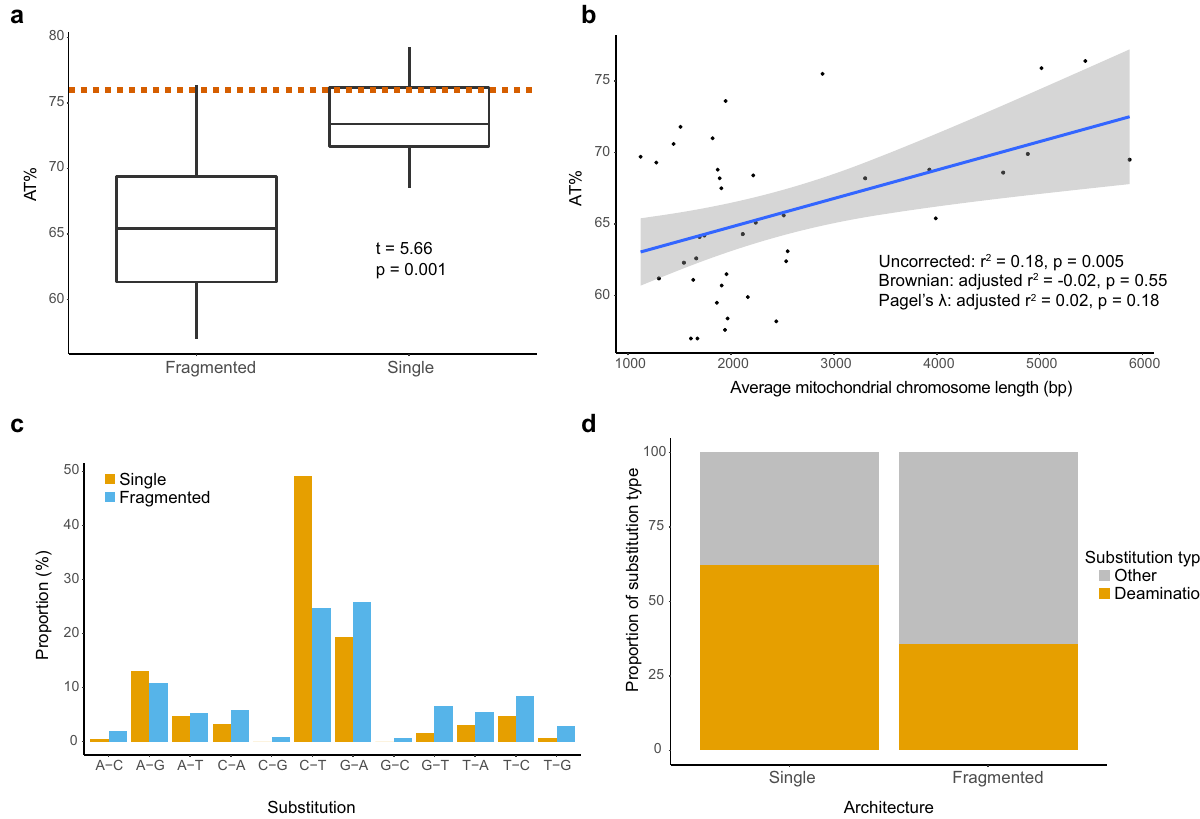
Fig. 5 Patterns of AT% in fragmented versus single-chromosome mitogenomes in parasitic lice. a Box-and-whisker plot comparing AT% from fragmented and single-chromosome mitogenomes in lice (center line: median; box limit: upper and lower quartiles; whiskers: interquartile range). AT% calculated from coding and non-coding regions. Dotted red line shows the average AT% for insect mitogenomes available on NCBI GenBank (76.0%). Signi fi cance determined with phylogenetically corrected t -test. b Mitochondrial chromosome length is positively correlated with AT% in lice with fragmented mitogenomes. Points represent individual species of lice, where AT% is calculated from the total sequences and length is averaged among all chromosomes. The blue line and gray section indicate predictions from the linear model along with 95% con fi dence interval for the model. Results from statistical analyses, including from both phylogenetically corrected and uncorrected models, are indicated in the bottom right. c Proportion of substitutions among fourfold degenerate sites in the mitogenomes of 36 individuals (5 taxa) of Columbicola (fragmented mitogenome) and 35 individuals (7 taxa) of Physconelloides (single mitogenome). d Proportion of deamination substitutions (C → T and A → G) relative to other substitutions among fourfold degenerate sites in the mitogenomes of Physconelloides (single mitogenomes) and Columbicola (fragmented